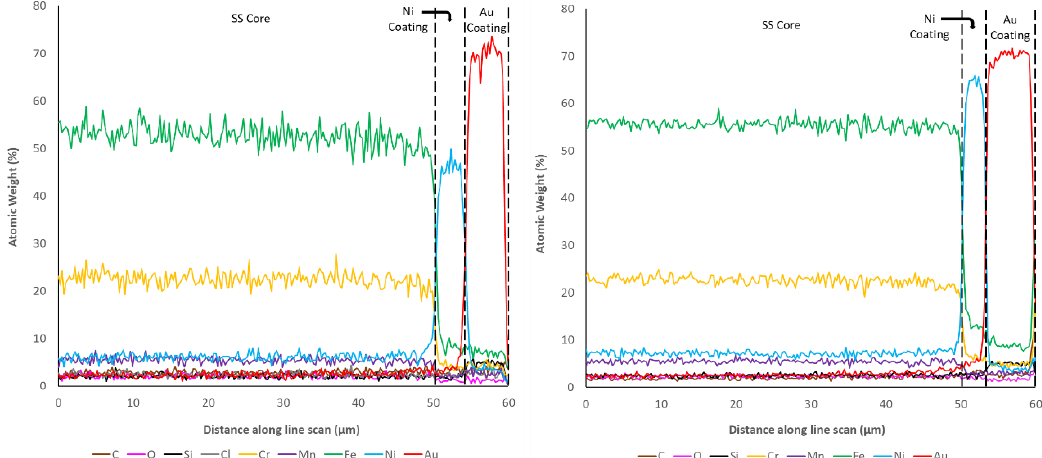
Figure 17. Element atomic weight distribution for the SS Ni + Au thin-walled pipe ( left , 4) and thick-walled pipe ( right , 5), at the core-coating boundary.